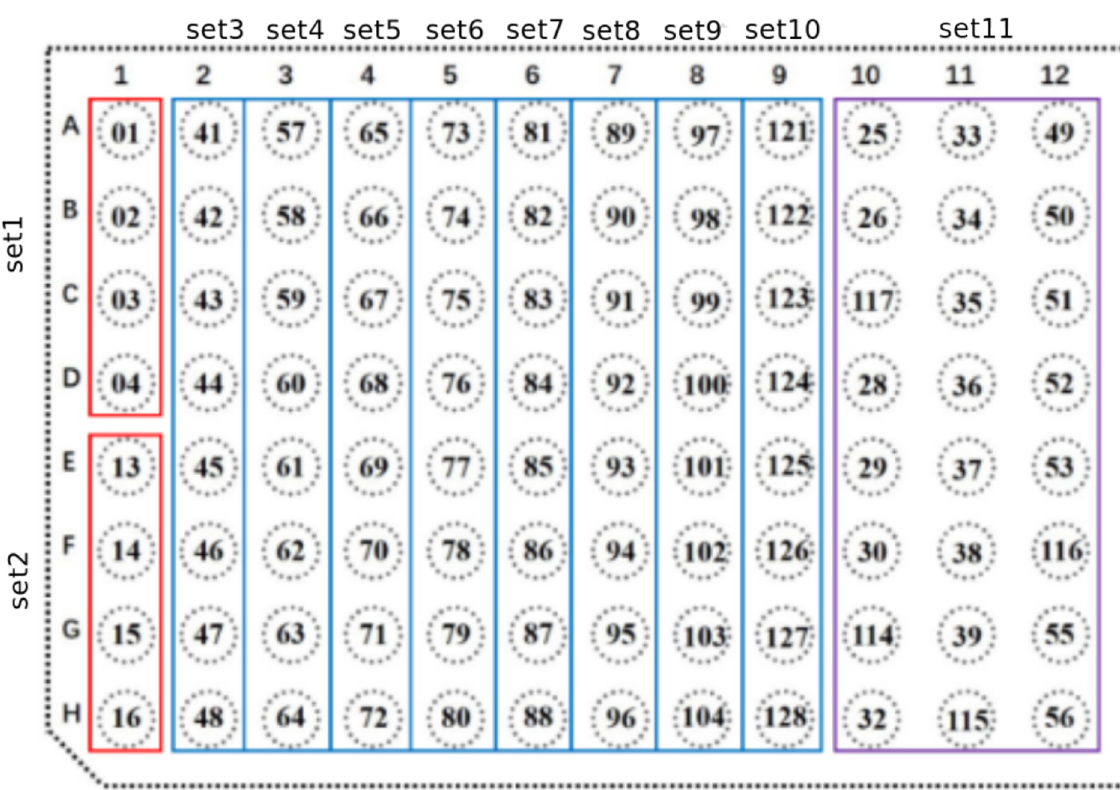
PLOS ONE | https://doi.org/10.1371/journal.pone.0247532 March 1,